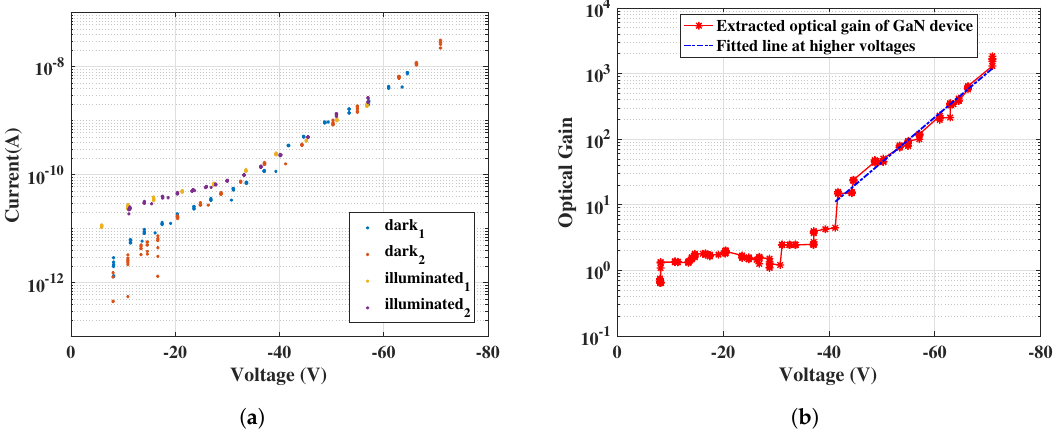
Figure 12. GaN sensor characteristics under UV illumination. ( a ) It can be seen that, for lower voltages, the dark current is lower than the photocurrent by a factor of 10, while, for higher voltages (>40 V), the dark current also increases as the APD starts avalanching. This characteristic is similar to results shown in Figure 1b. ( a ) I–V curve under UV illumination; and ( b ) optical gain estimated from Figure